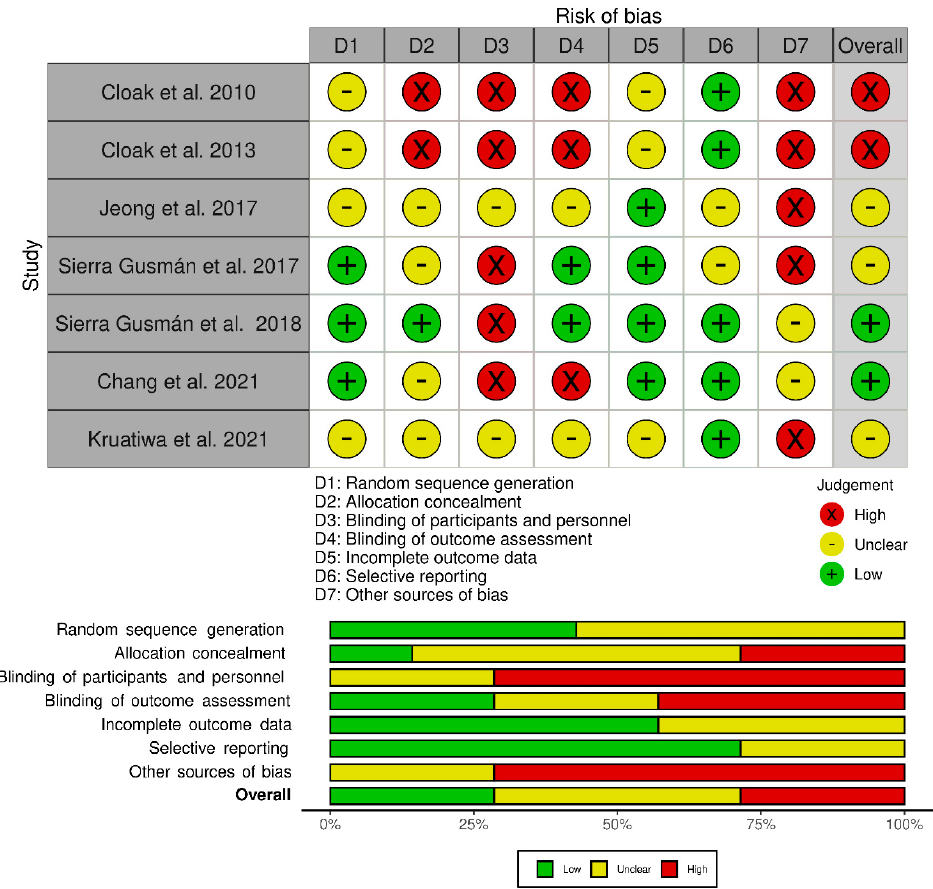
Figure 3. Assessment for risk of bias for the included studies